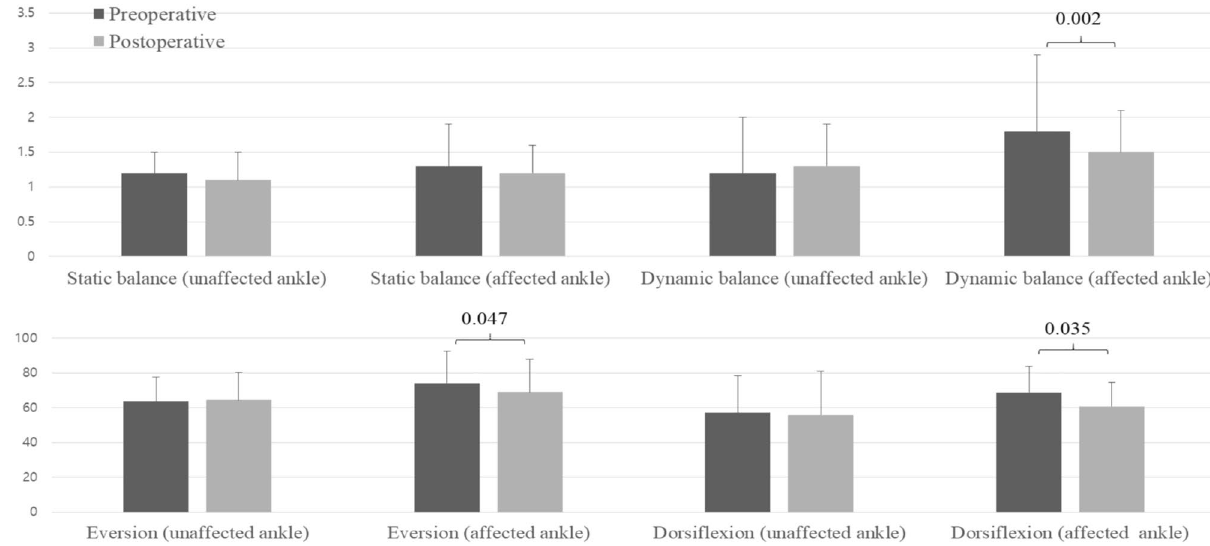
Figure 2. Pre- and postoperative postural stability (degrees) and time to peak torque (milliseconds) of the affected versus unaffected ankles between preoperative and postoperative in the MBP group. MBP modified Broström procedure.